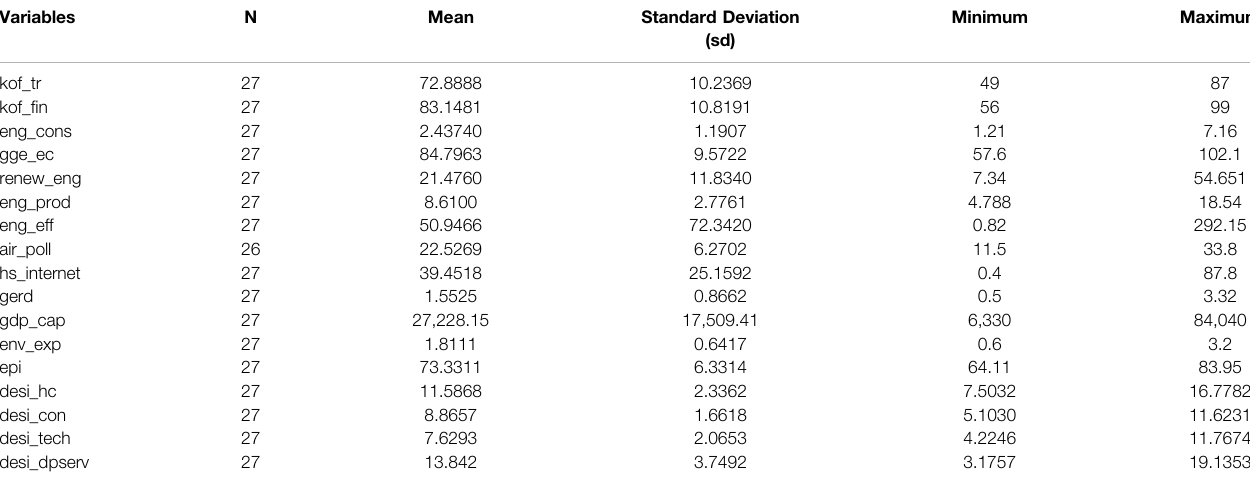
Authors ’ contribution.